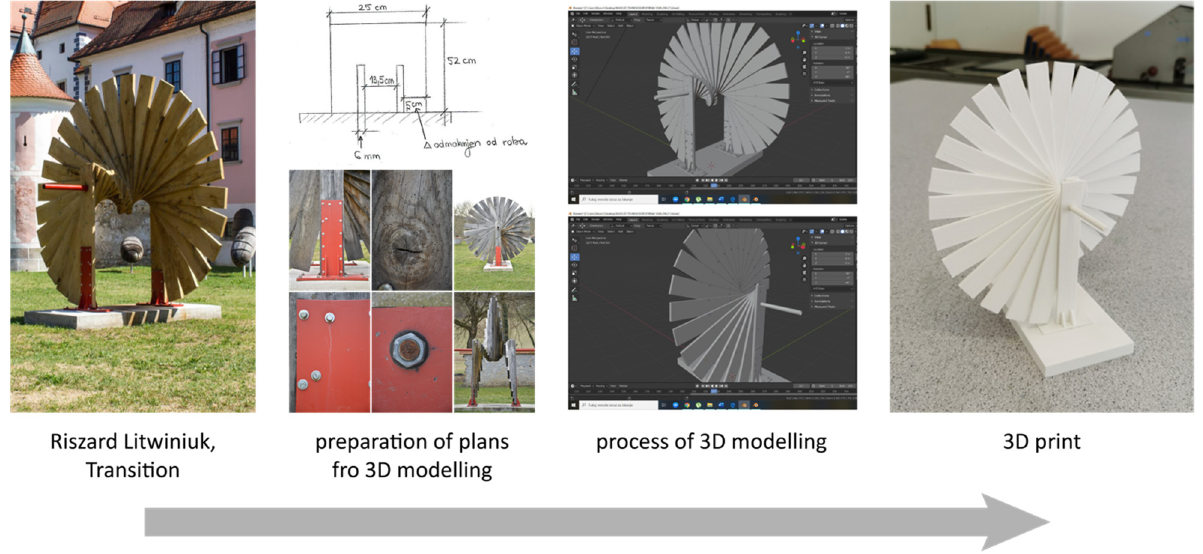
Figure 8. The process of the technological approach to the reconstruction of the sculpture “Transi- tion”, Ryszard Litwiniuk, 2017 by the process of 3D modelling (authors: Eva Bužanin, Monika Samsa, Nejc Suhadolnik).